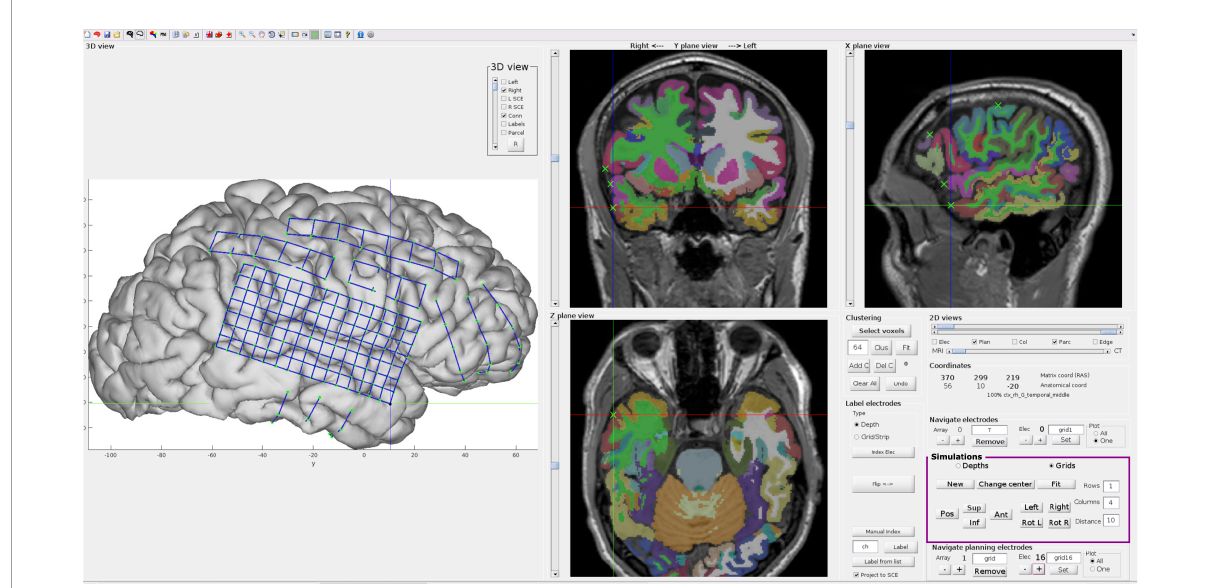
FIGURE10 Interactive electrode simulations on a patient’s native brain anatomy. Example of electrodes simulated on a native space brain anatomy using the interactive GUI provided in iElectrodes. The controls (magenta box) are used for displacing and rotating 2D flat grid or strip models over the SCE surface (similar to Figure 2D ). The 3D view is particularly useful for defining the location of the arrays in relation to the lateral pial surfaces, whereas the 2D views help to identify their relation to sulci and deep structures. When the desired location and orientation are achieved, arrays are fitted to the SCE surface. For depth electrodes, target and entry points are manually defined in the 2D views. The 2D slices show the Destrieux atlas (color coded), the T1-weighted MRI image, and the simulated coordinates (green ‘ x ’), making the anatomical identification of the arrays easier. Note that electrodes were fitted to the SCE surface, but the pial brain surface is shown for illustrative purposes. SCE, smooth cortical envelope. GUI, graphical user